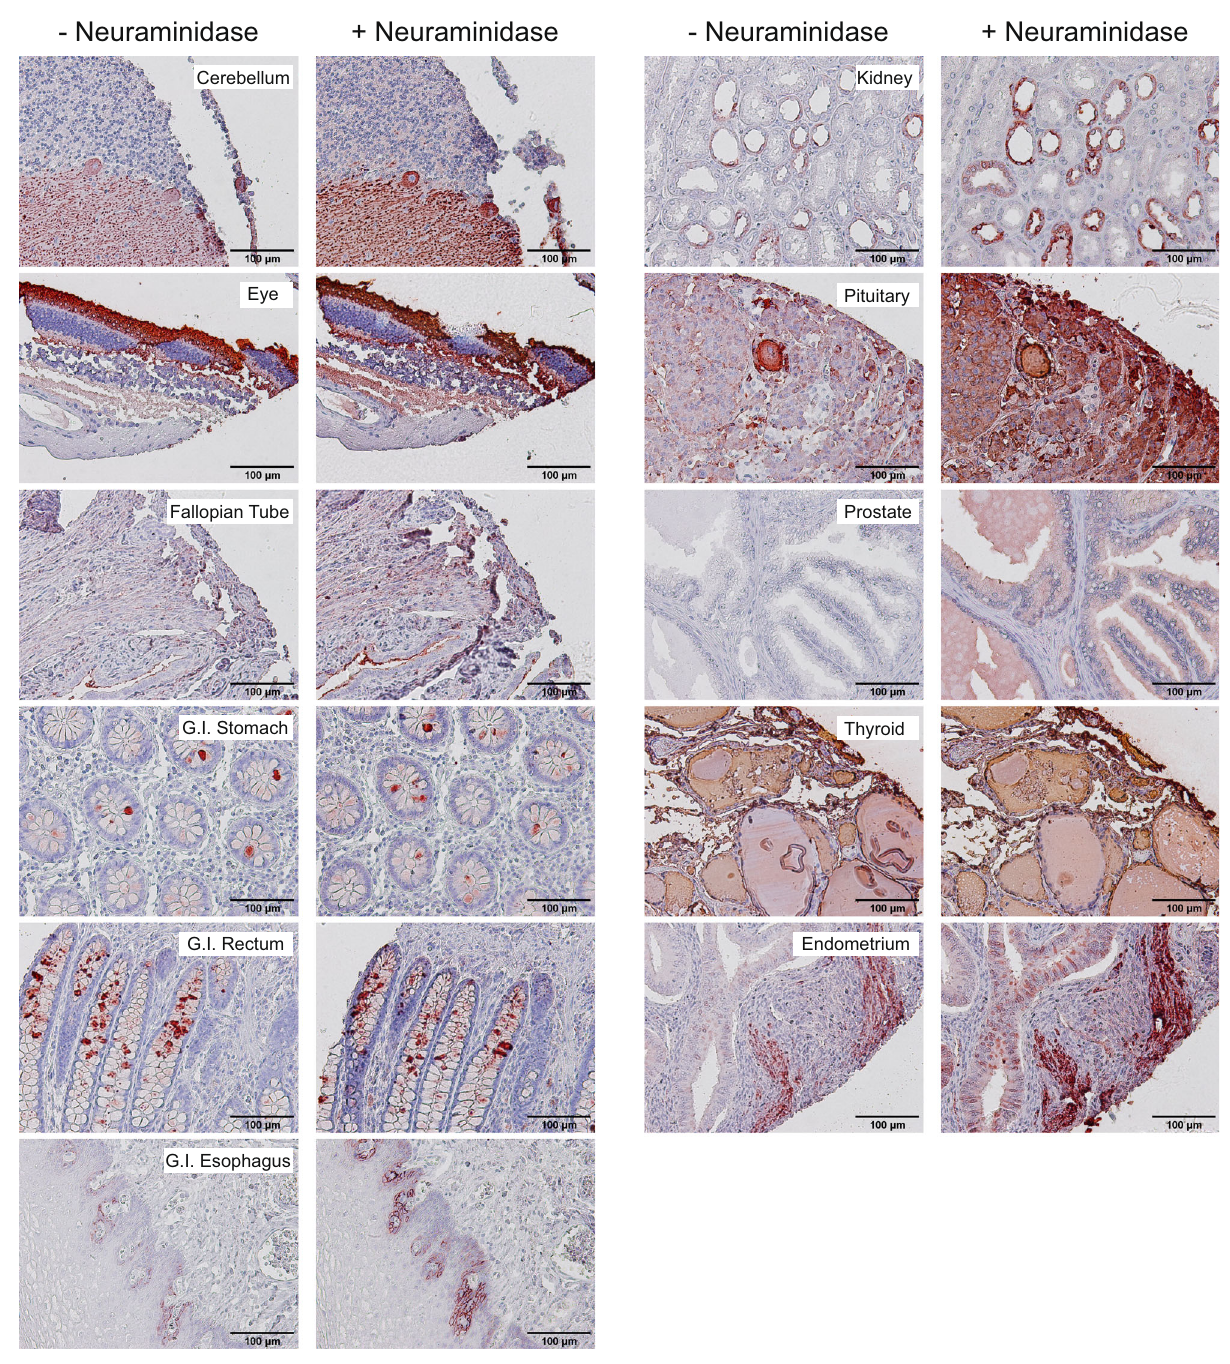
Fig. 6 IHC of healthy human tissues with O6. Several tissues stained positive with O6, including cerebellum, eye, fallopian tube, G.I.-stomach, G.I.-rectum, G.I.-esophagus, kidney, pituitary, prostate, thyroid, and endometrium. The left panels depict the staining pro fi le prior to neuraminidase treatment and the right panels are after ( + ) neuraminidase. Scale bars are noted on each